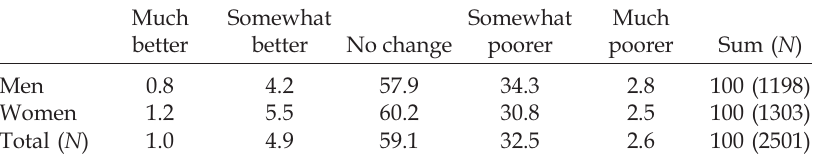
Table 3. Subjecti v e changes in work ability o v er the last ten years